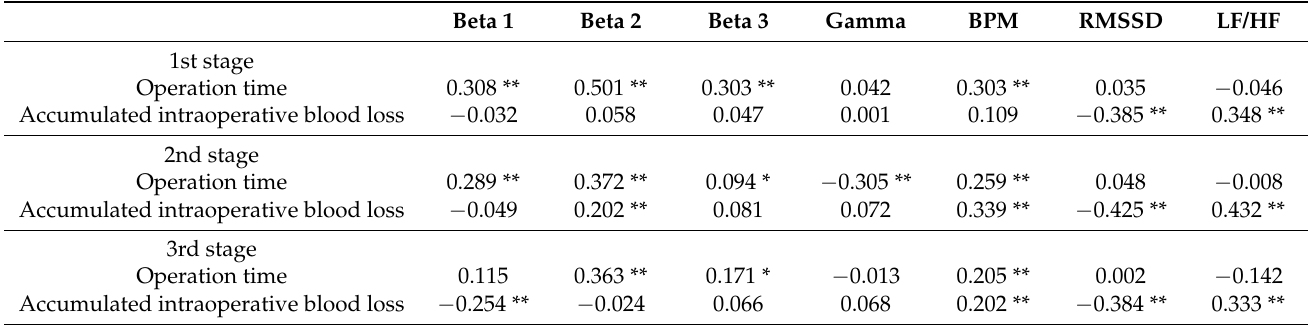
Table 4. Correlation Analysis Between the Stress-Related Parameters of the Surgeon in Tourniquet Applied Orthopedic Surgery. * p < 0.05, ** p < 0.01 Beta 1: low beta waves, 12–15 Hz; Beta 2: mid-range beta waves, 15–20 Hz; Beta 3: high beta waves, 20–30 Hz; Gamma: 30–50 Hz; BPM: beats per minute, RMSSD: square root of the mean R-R interval; LF: low frequency, HF: high